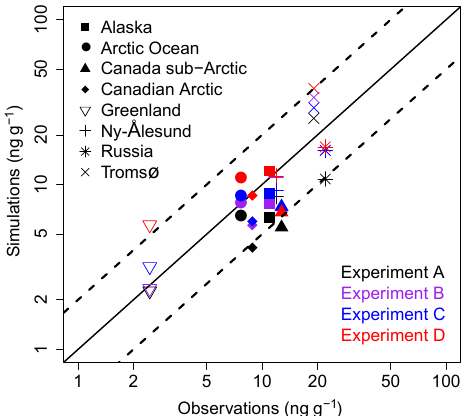
Figure 3. Observed and GEOS-Chem simulated median BC con- centration in snow (ngg − 1 ) in the eight sub-regions in the Arctic (see Fig. 1). Solid line is 1 : 1 ratio line and dashed lines are 1 : 2 (or 2 :